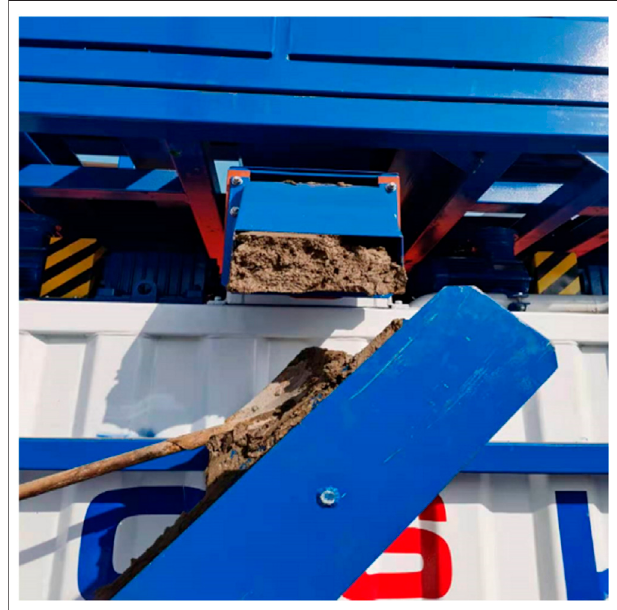
FIGURE 7 | On-line solid – liquid separation process in fi eld.